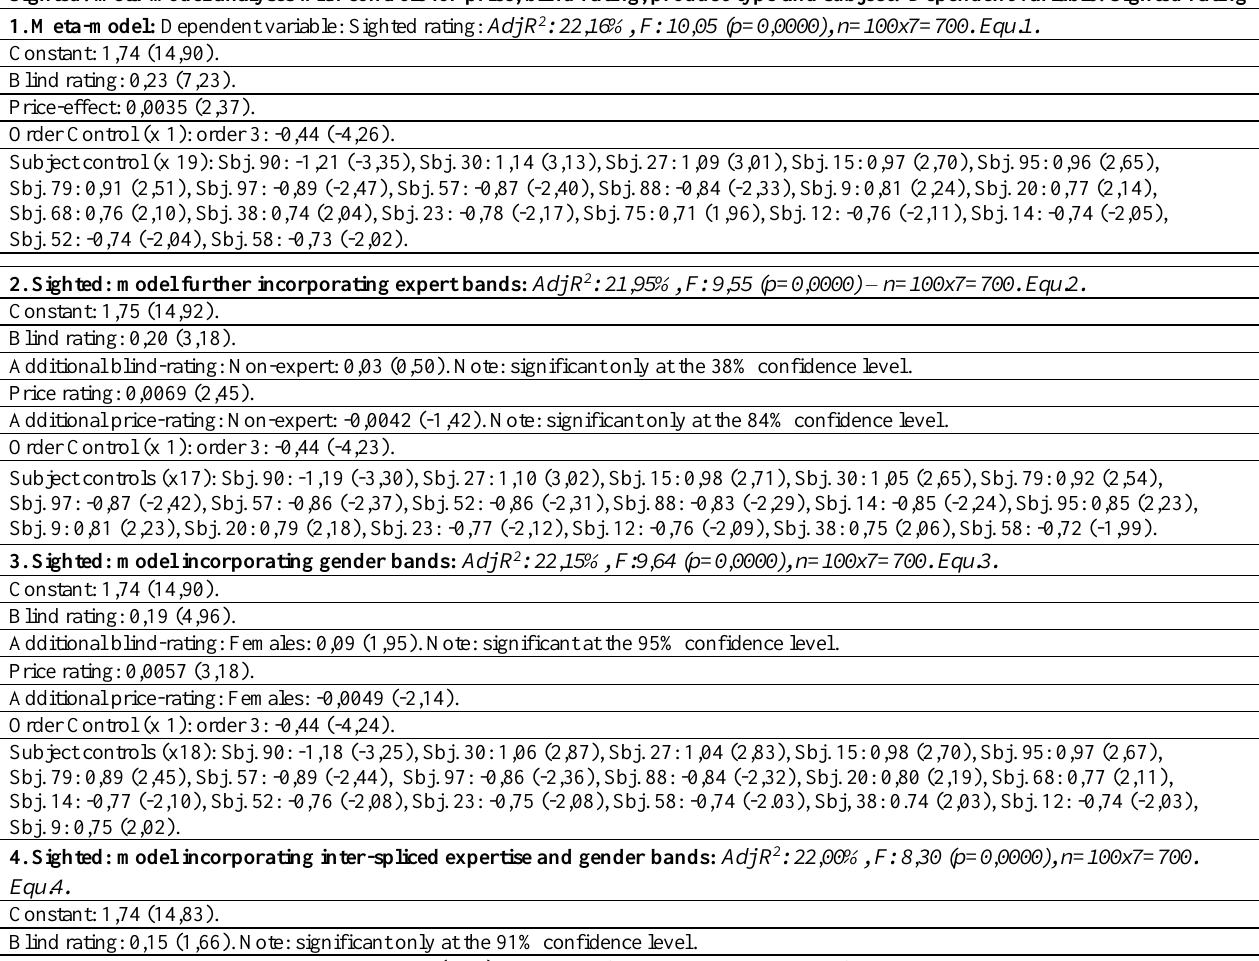
Table 3: OLS regressions explaining sighted assessments described in equations 1 to 4 Sighted: meta-model analyses with controls for price, blind rating, product-type and subject. Dependent variable: Sighted